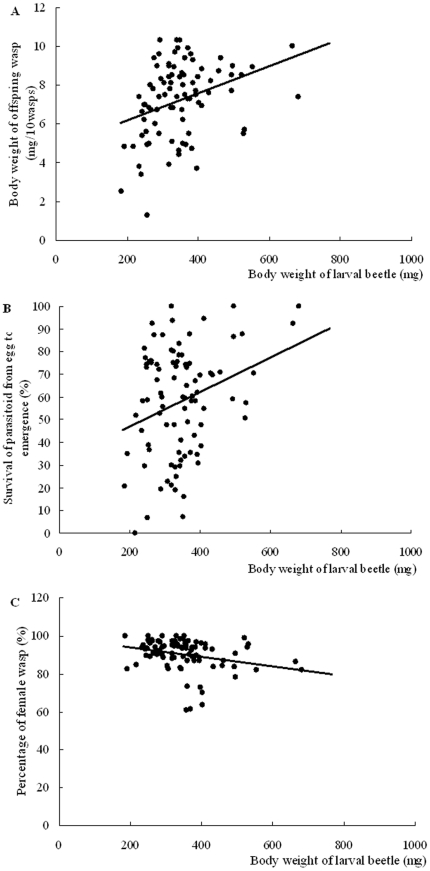
Correlation between Monochamus alternatus larvae size and Sclerodermus harmandi offspring fitness indices.Effect of host size is assessed separately for (A) offspring body size (y = 0.0069×+4.8103, r2 = 0.0.113, F1,84 = 10.706 p = 0.002), (B) offspring survival (y = 0.0761×+31.913, r2 = 0.086, F1,88 = 8.299, p = 0.005), and (C) Offspring sex ratio (female percentage) (y = −0.0246×+98.916, r2 = 0.0764, F1,85 = 7.035, p = 0.01).